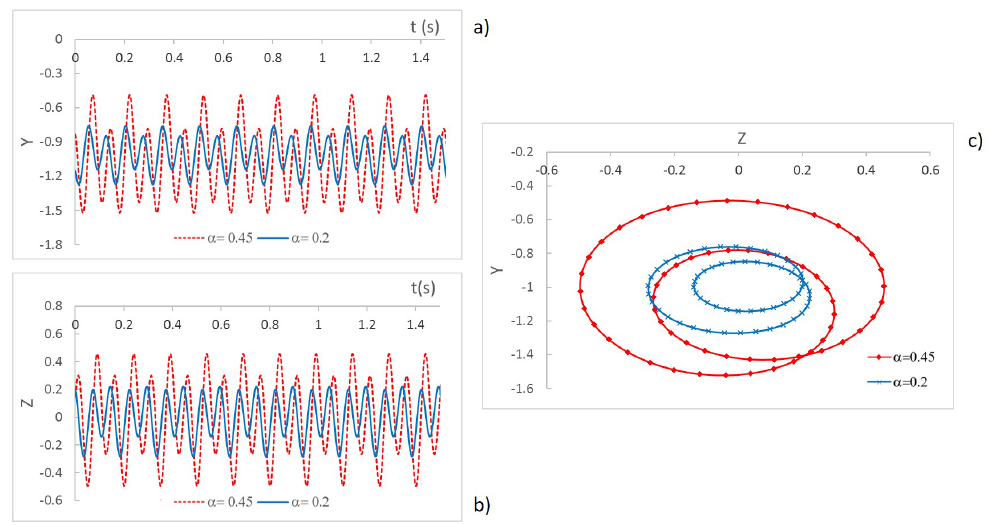
Figure 2. Displacement in mm: ( a ) Y direction, ( b ) Z direction, ( c ) orbits ( p = 0.495).